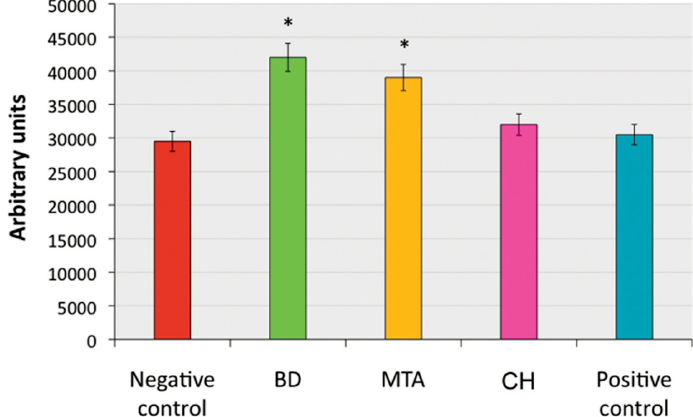
Figure 3- Migration of stem cells from human exfoliated deciduous teeth (SHED) toward medium conditioned by incubation with calcium hydroxide (CH), mineral trioxide aggregate (MTA) or Biodentine TM (BD). Serum-starved SHED could migrate through 8-µm pore-size inserts (in companion plates) overnight, and the number of migrating cells was estimated by staining with Cell Tracker™ Green CMFDA. Regular growth medium (alpha-MEM with 10% FBS) or medium with 20% FBS were used as negative and positive control, respectively. Data represent mean ± SD (n=3 independent experiments, performed in triplicates). *p<0.05 (one-way analysis of variance)